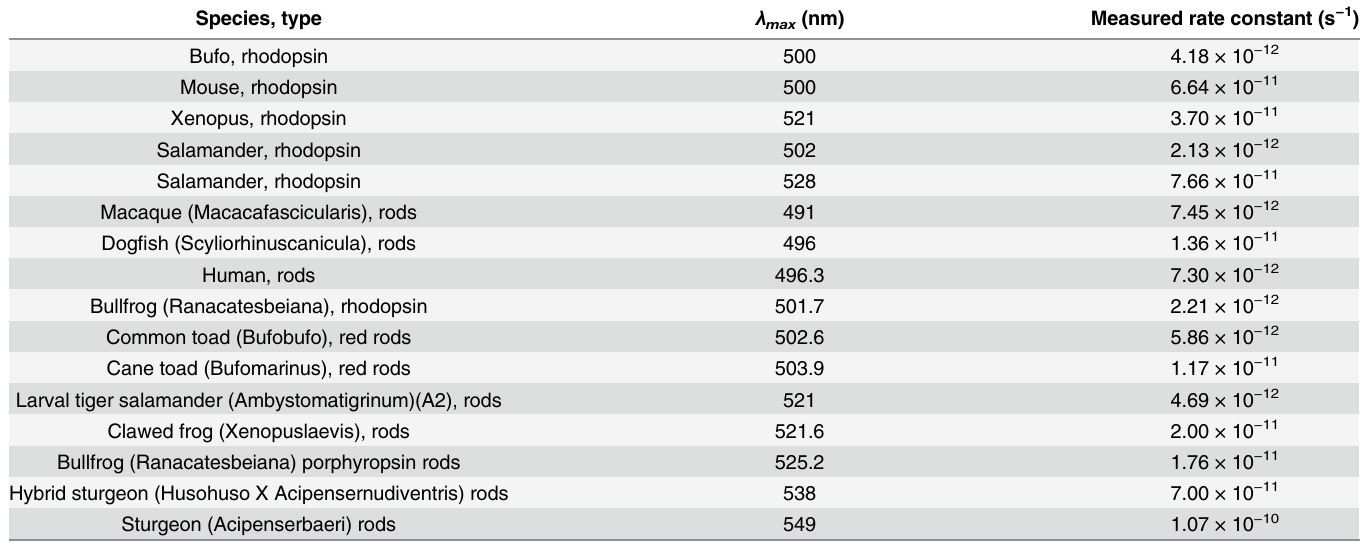
Table 2. Data set I consisting of rods and rhodopsins. Data are taken from Luo et al. [2], which are measured/obtained at 23°C, and from Ala-Laurila et al. [9] at 21°C. It can be simply shown that the difference between measurements at these two temperatures is trivial and does not affect the values. Species, type